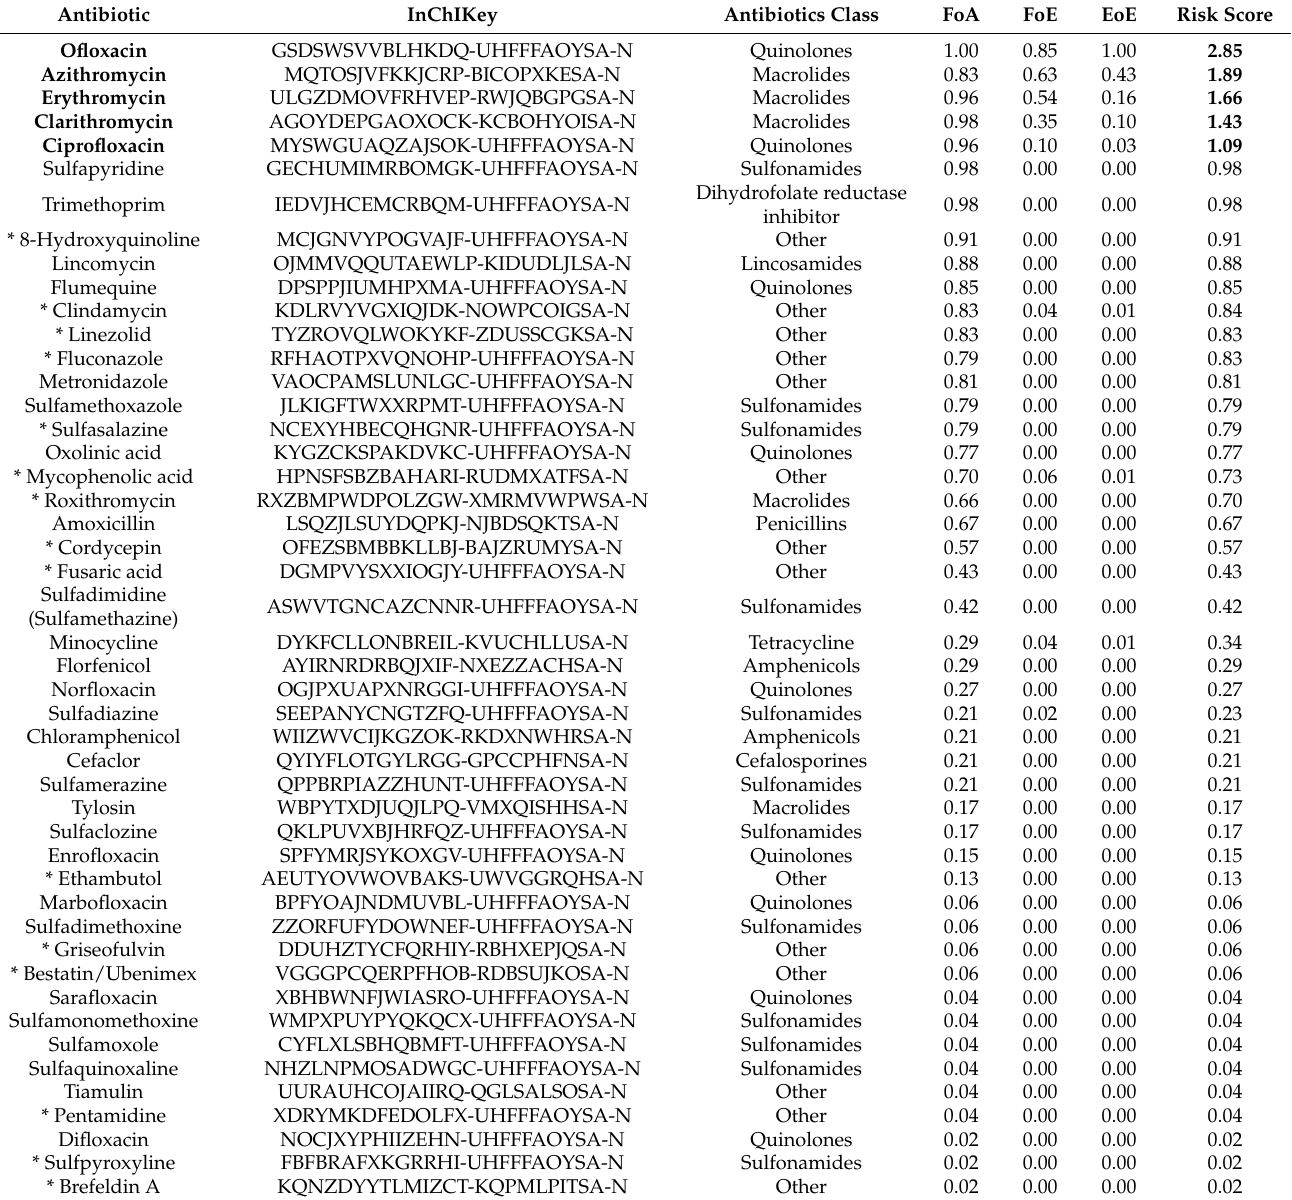
Table 1. Antibiotics detected in effluent wastewater samples (from target and suspect